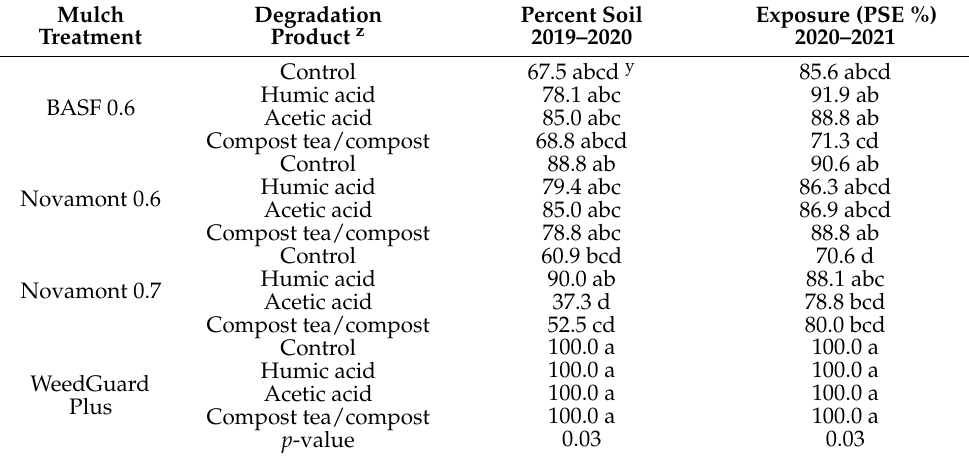
Table 6. Surface deterioration measured as percent soil exposure (PSE) of soil-biodegradable mulch (BDM) following application of degradation products, using split-plot analysis of variance (ANOVA). Field experiments were established in Spring 2019 and Spring 2020 testing three plastic BDMs (BASF 0.6, Novamont 0.6, and Novamont 0.7) and one cellulose paper mulch (WeedGuard Plus). Potentially degrading products (compost tea, dairy-based compost, acetic and humic acids) were surface applied in autumn and spring.